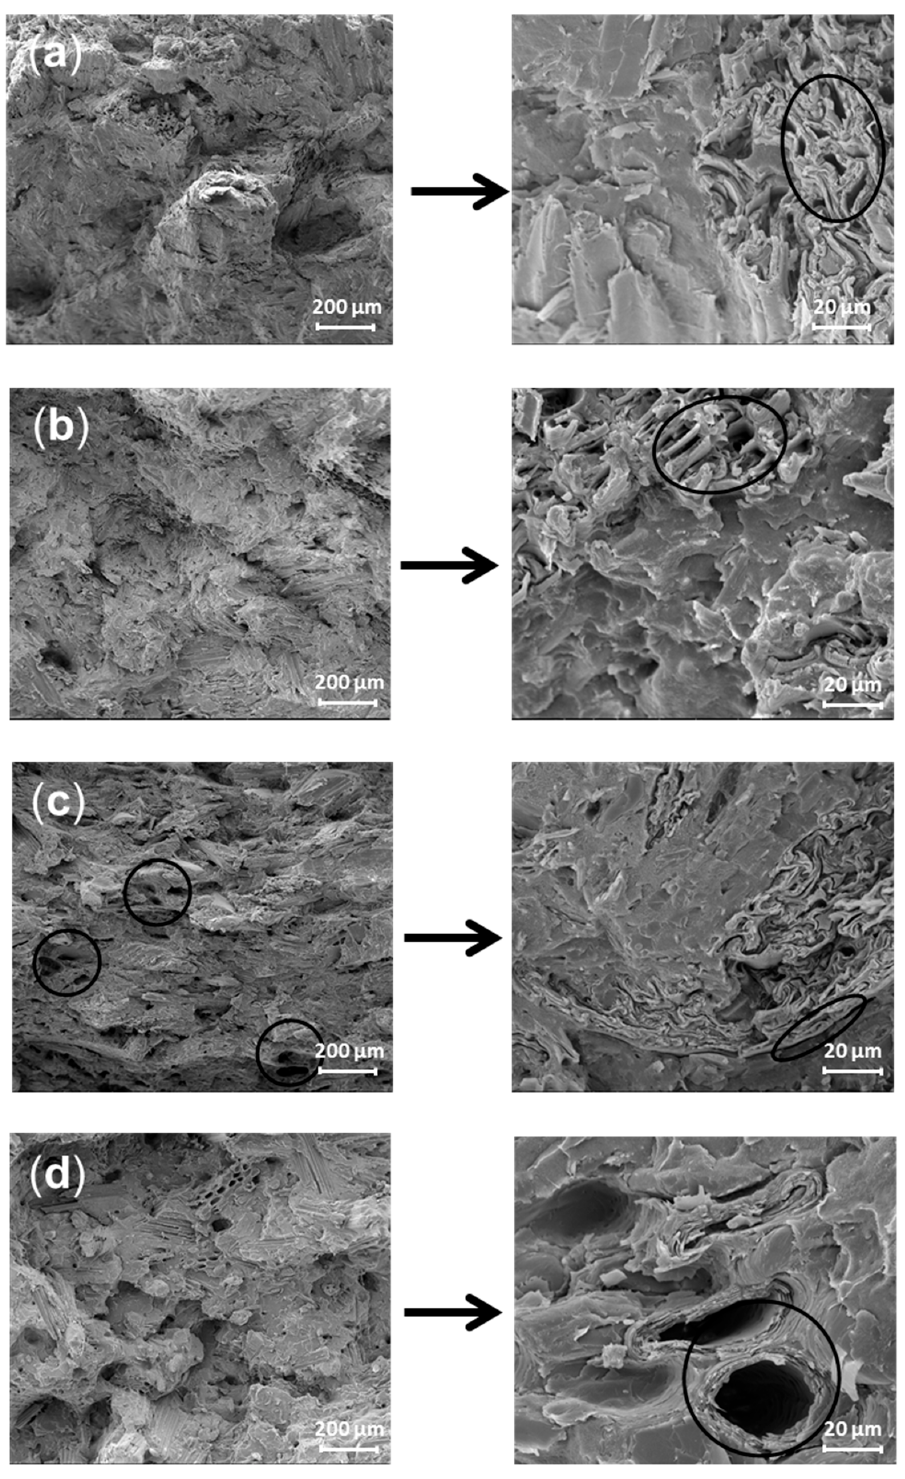
Figure 3. Scanning Electron Microscope (SEM) micrographs of the fractural surface of composites after creep test: ( a ) poplar/HDPE; ( b ) radiata pine/HDPE; ( c ) wheat straw/HDPE; ( d ) moso bamboo/HDPE.